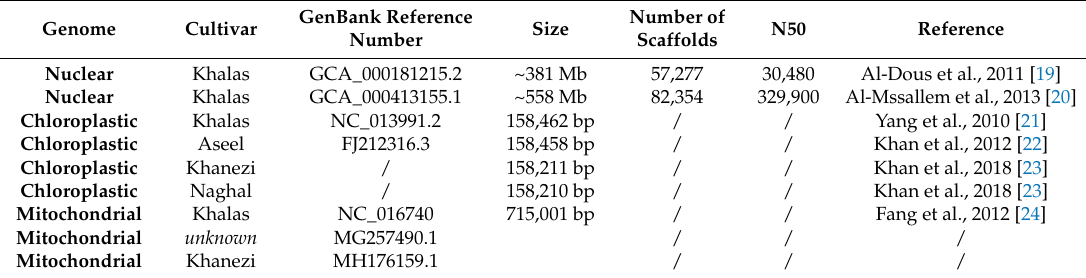
Table 1. List of nuclear and organellar assembly of date palm in September